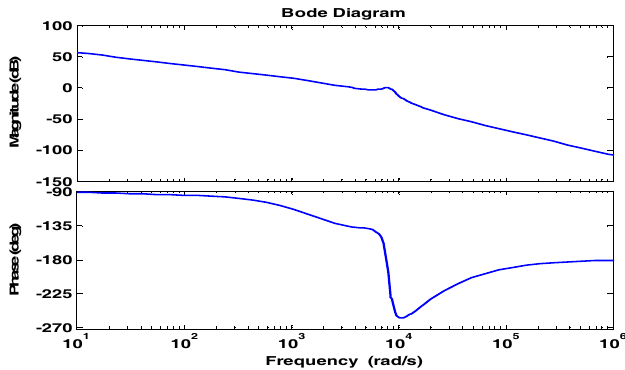
Figure 19. Bode plot for PR-D control of grid connected inverter by LCL filter.